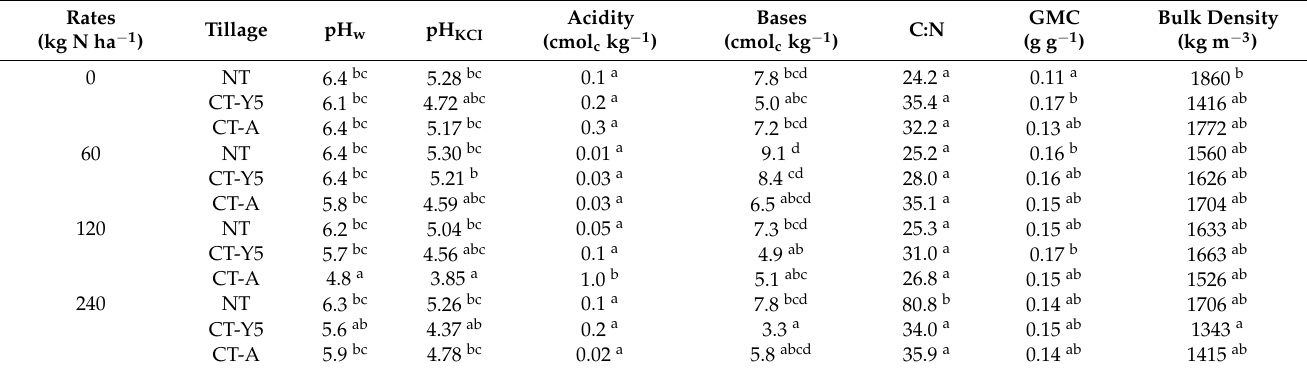
Table 2. Soil characteristics under different tillage systems and N fertilizer application rates at 10–20 cm